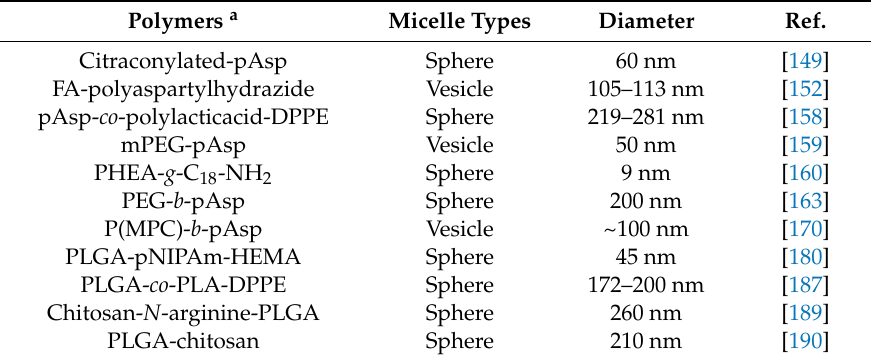
Table 3. Anionic polypeptide based self-assembled micelles.